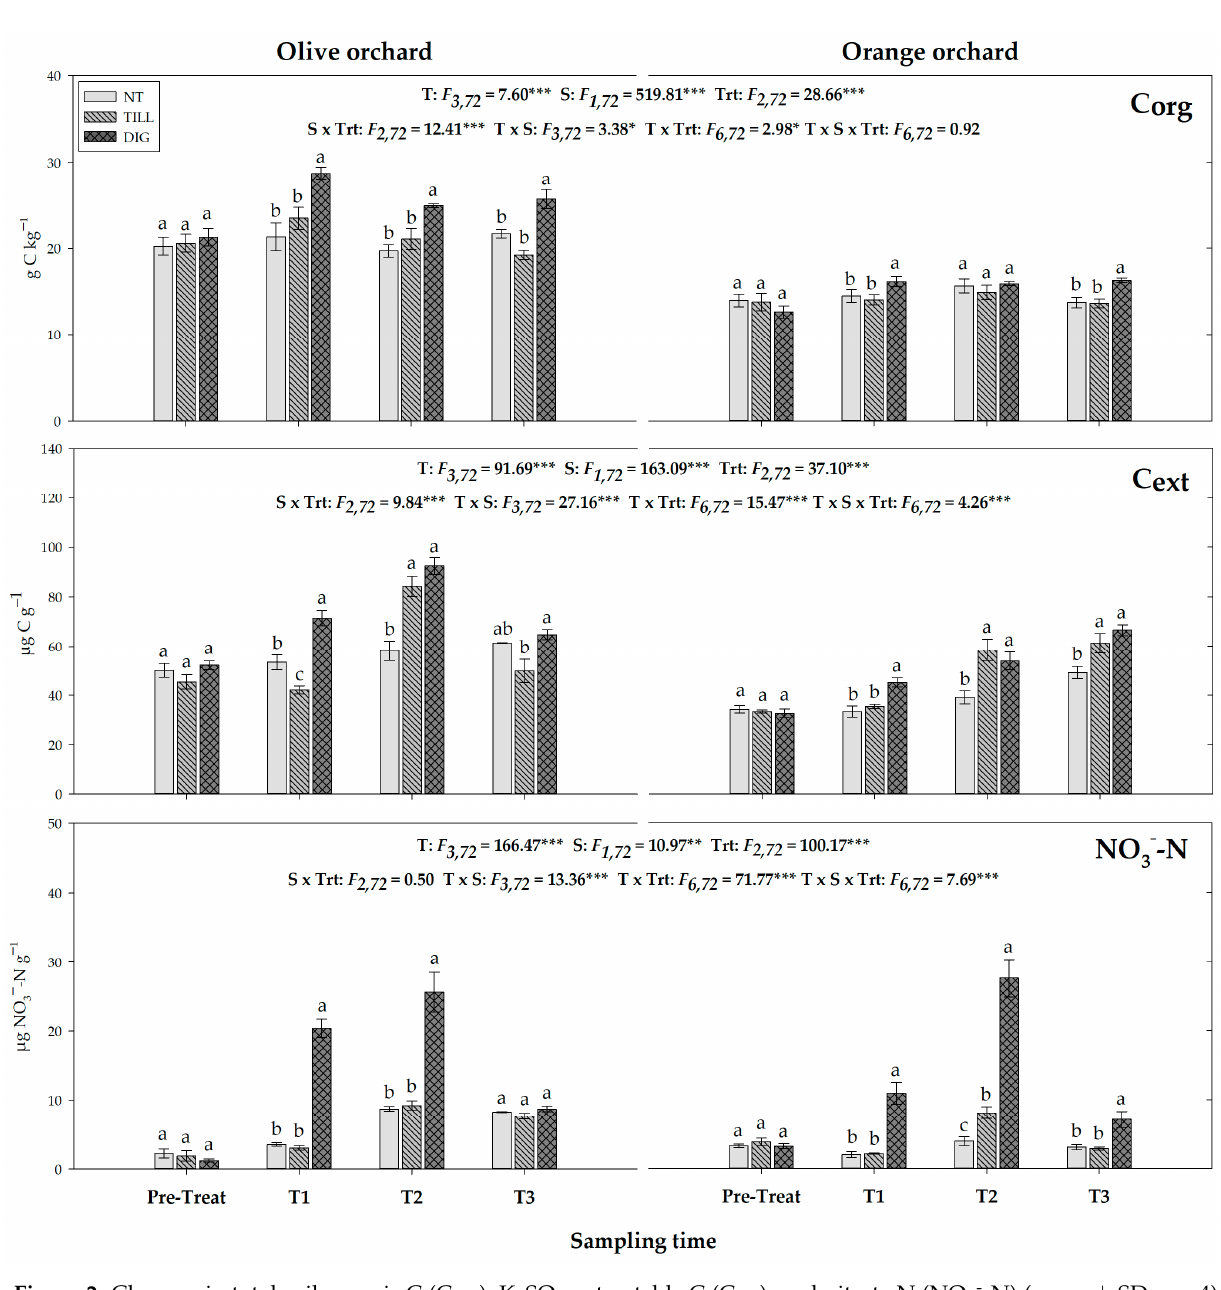
Figure 2. Changes in total soil organic C (C org ), K 2 SO 4 -extractable C (C ext ), and nitrate N (NO 3- -N) (mean ± SD, n = 4) in the field plots arranged in an olive and an orange orchard under different treatments—no-tillage (NT), conventional tillage (TILL), solid anaerobic digestate amendment (DIG)—at four sampling times (from May to September) during the 2016 growing season. Within each sampling period, different letters indicate significant differences among treatments (Tukey’s HSD test, p < 0.05). Significant effects due to time (T), soil type (S), soil management (Trt), and their interactions are presented as F-values, and level of significance (* p < 0.05, ** p < 0.01, *** p < 0.001) was estimated by a three-way ANOVA (time × soil × management).